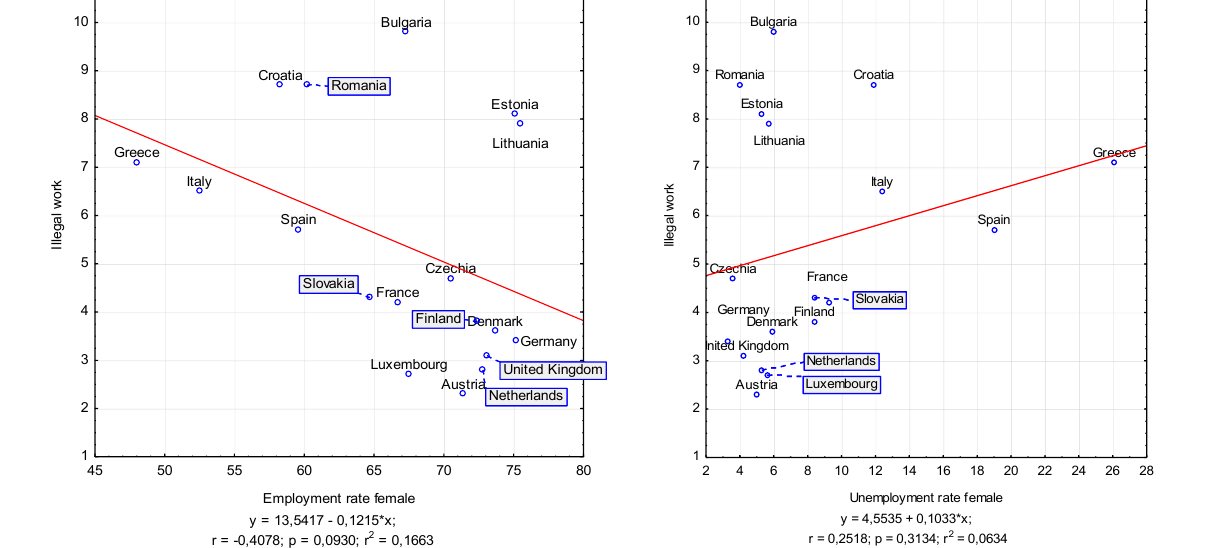
Figure 5. Regression model for illegal work in terms of unemployment rate for women in the selected European Union countries